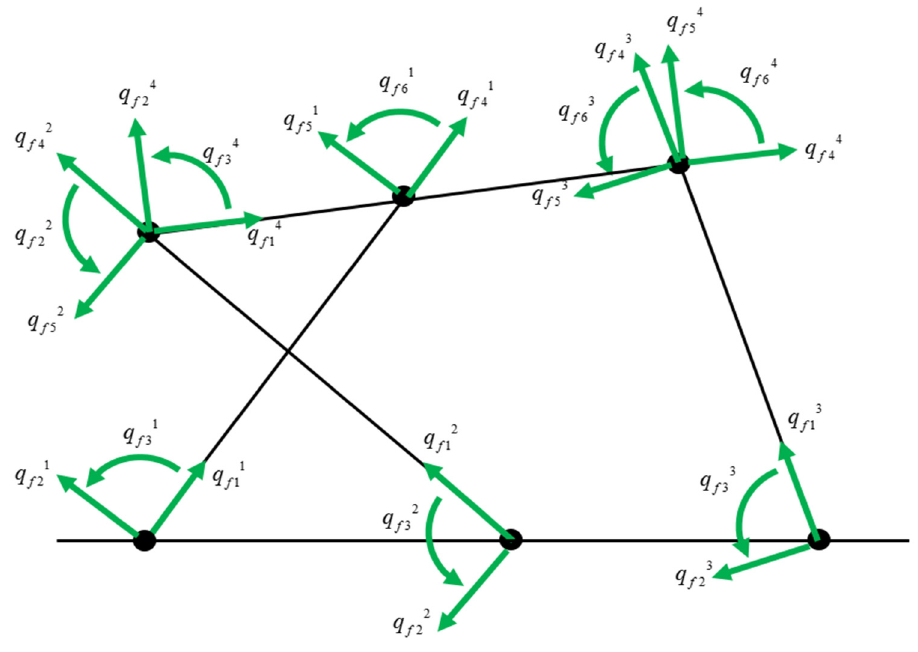
Figure 5. The elastic nodal coordinates in a planar 3PRR manipulator.